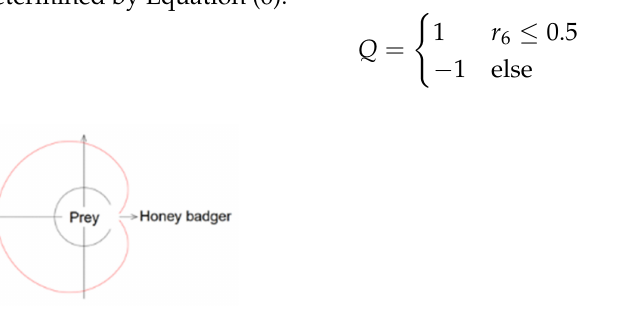
Figure 2. Schematic diagram of honey badger movement in excavation